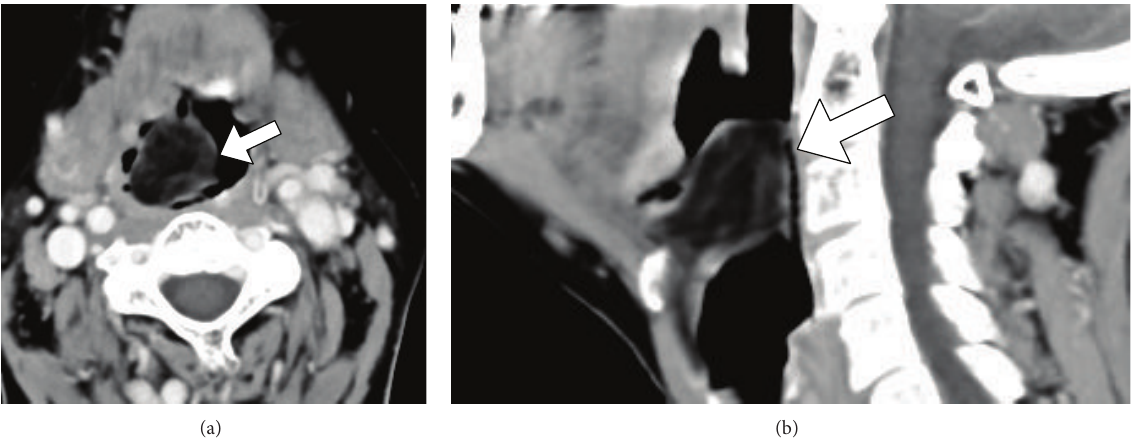
Figure 2: Contrast-enhanced (a) axial and (b) sagittal CT images showed a lipoma occurring on the lingual surface of the epiglottis (arrows).